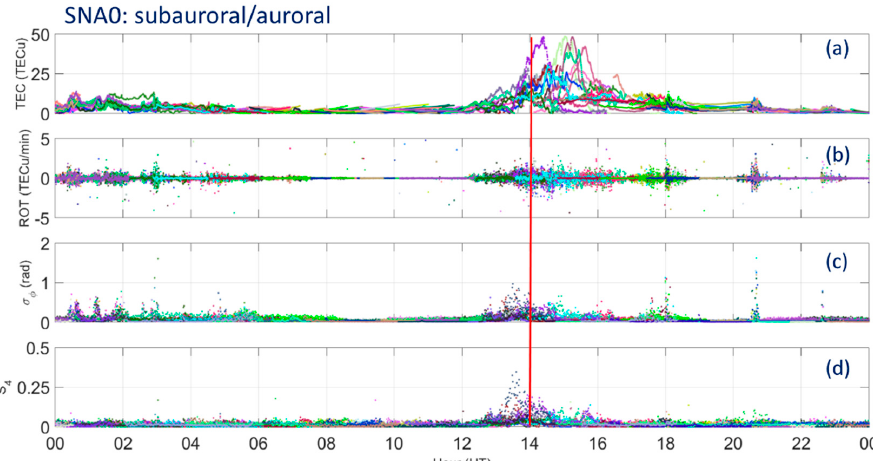
Figure 2. GNSS data from the receiver located at SANAE IV base (SNA0) on 8 September 2017. From top to bottom: Total Electron Content (TEC, a ), Rate of TEC change (ROT, b ), phase scintillation index ( σ φ , c ) and amplitude scintillation index ( S 4 , d ). Different colors refers to different satellites in view of the receiver. Red vertical line highlights the local magnetic noon.